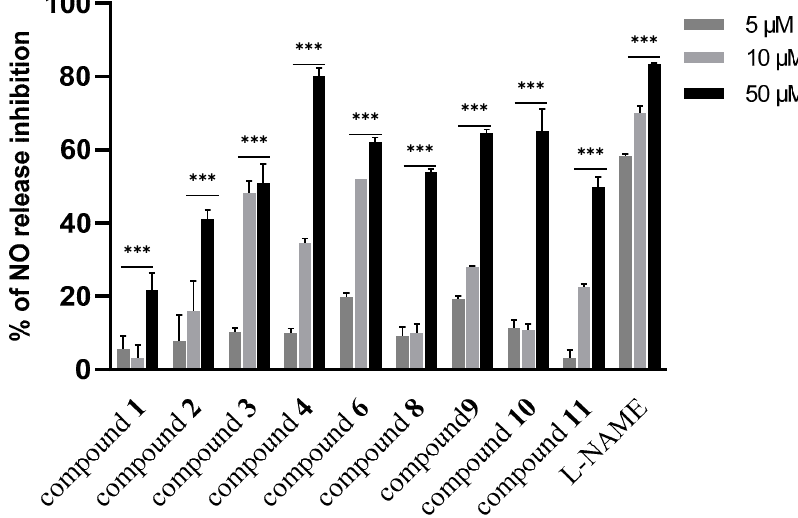
Figure 4. Effect of isolated compounds from aerial parts of Dionysia diapensifolia on NO release inhibition in J774A.1 macrophages (n = 3). Data are expressed as mean ± S.E.M.; *** denotes p < 0.001 vs. LPS (1 µg/mL). L-NAME (5, 10, and 50 µM) was used as a positive control.